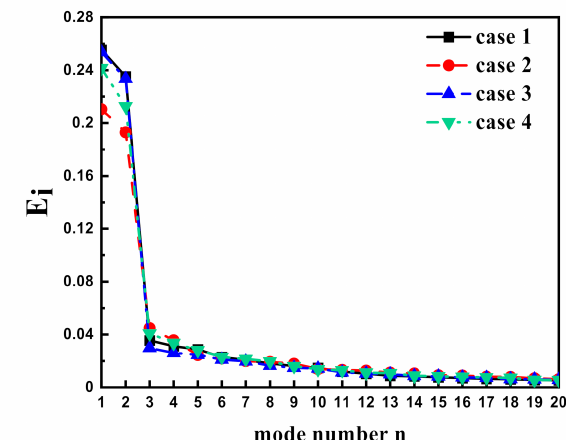
Figure 10. The energy contained by POD modes for all cases for the smooth cylinder and the dimpled cylinder with different